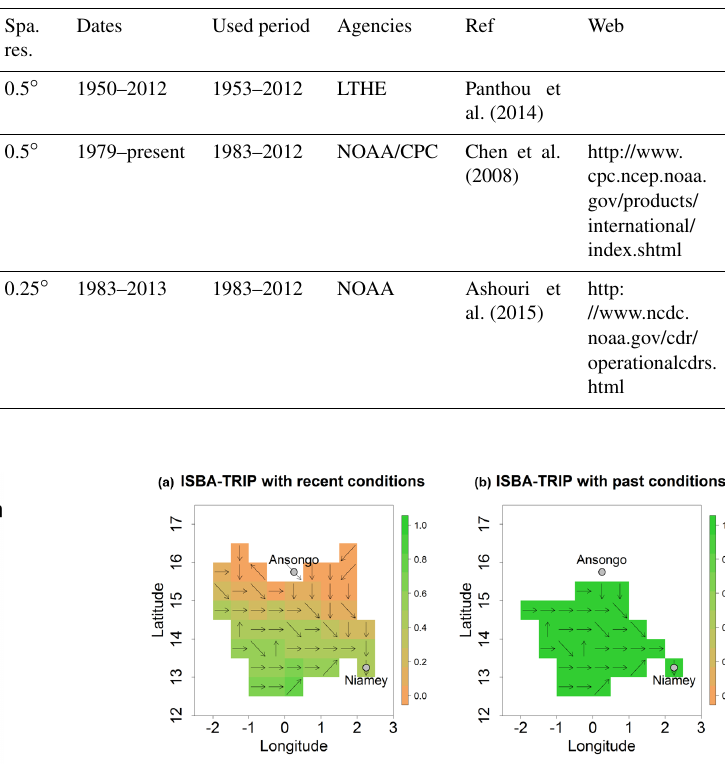
Figure 4. ISBA–TRIP domain implemented on the Ansongo– Niamey reach basin. The colour scale represent the vegetation frac- tion on the area. Green colour and values close to 1 indicate full vegetated cells and brown colour and values close to 0 indicate bare